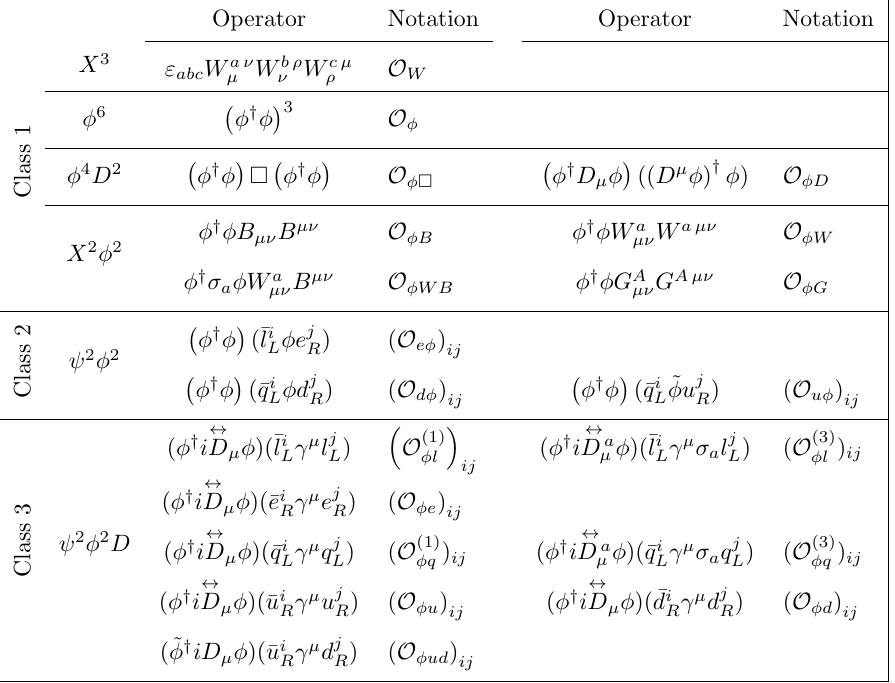
! D a (cid:17) (cid:27) (cid:0) D and G A a (cid:22) (cid:22) (cid:27) a , while B (cid:22)(cid:23) , W (cid:22) (cid:22)(cid:23) (cid:22)(cid:23) (cid:0) (cid:22) (cid:1) (cid:0) (cid:22) (cid:1) l 1 (cid:13) (cid:22) l 2 l 2 (cid:13) (cid:22) l 1 , which modi(cid:12)es the prediction for the muon